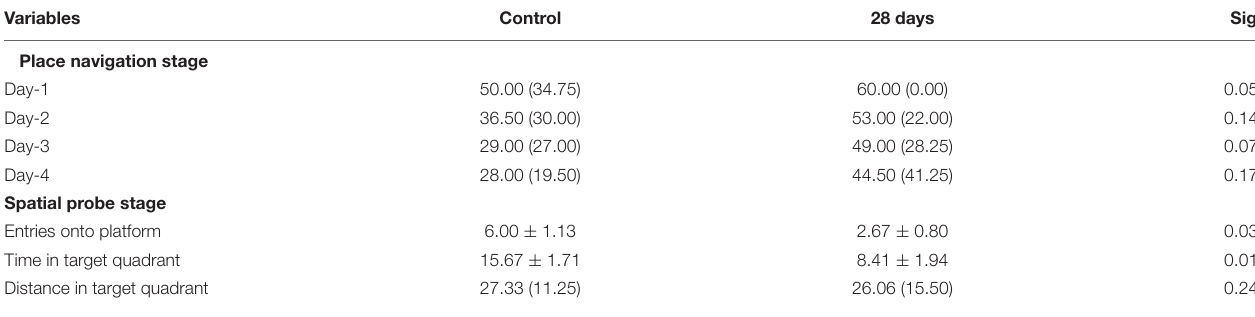
TABLE 3 | Basic data of